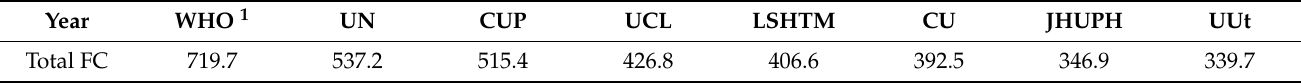
Table 5. The top eight institutes with the most FCs of citations from 2013 to 2022.